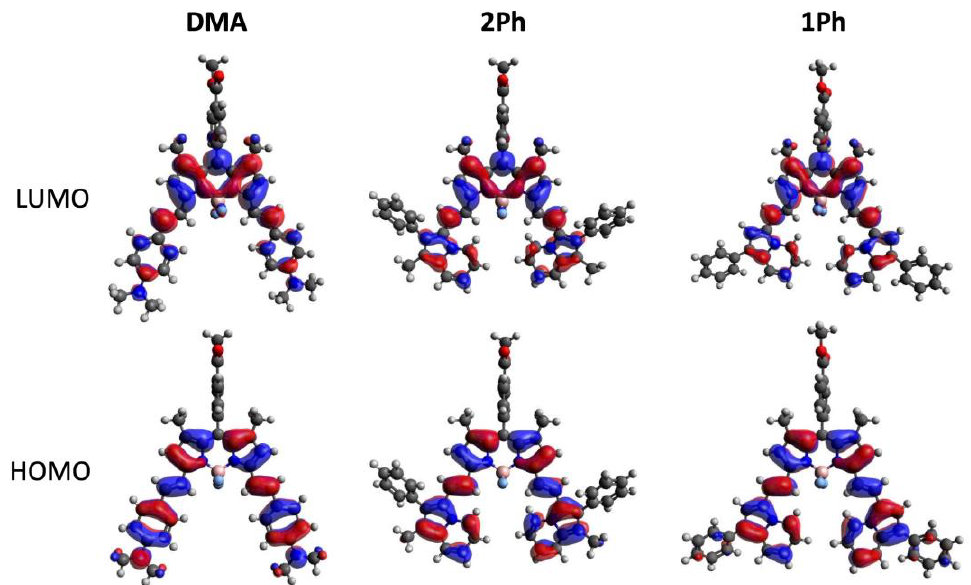
Figure 2. HOMO ( bottom ) and LUMO ( top ) orbitals for the three BODIPY dyes ( DMA , 2Ph , and 1Ph ).